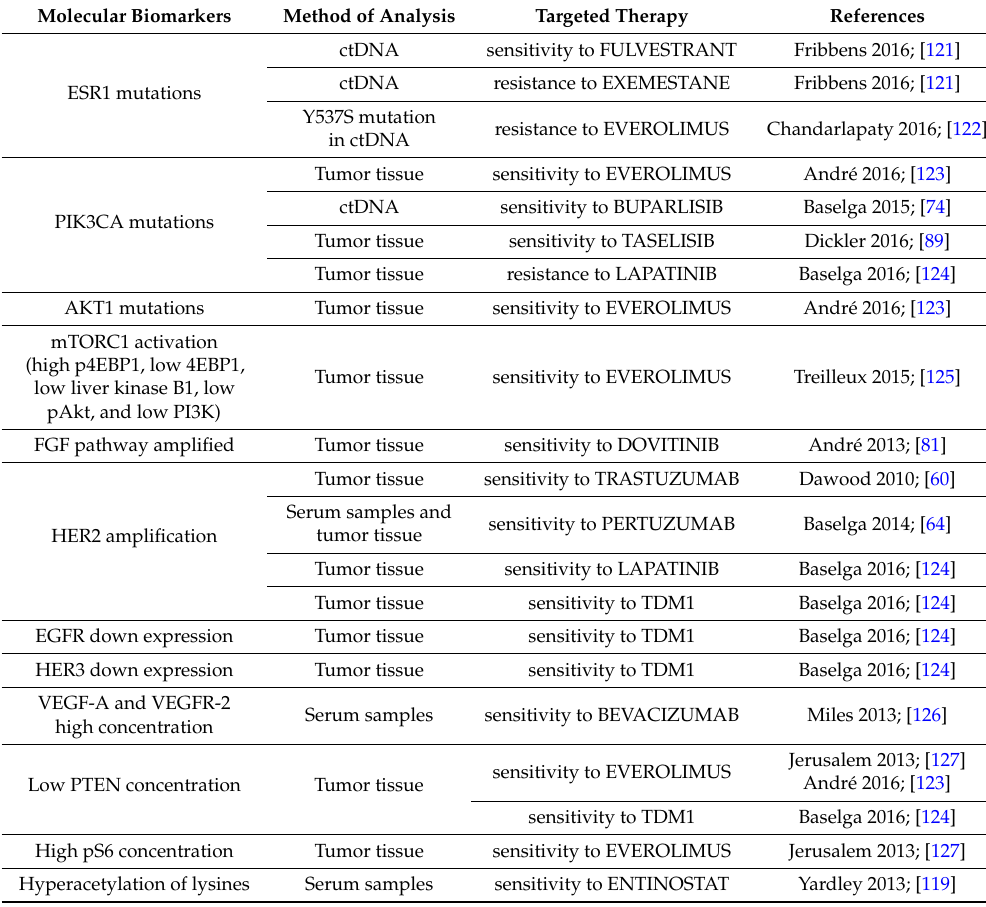
Table 1. Molecular biomarkers predictive of response to targeted treatment in clinical